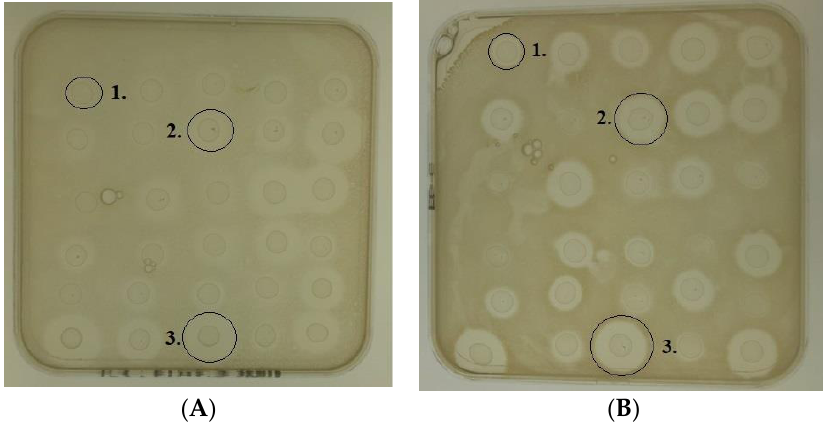
Figure 1. Representative pictures of the agar based deferred antagonism assays that were performed with a wildtype producing L. lactis strain and 29 L. lactis strains that produce bioengineered nisin A derivatives. These strains were spotted onto GM17 agar and grown at 30 ◦ C overnight after which they were overlaid with tryptone soy agar (TSA) inoculated with ( A ) Staphylococcus epidermidis 28 and ( B ) Staphylococcus epidermidis 53. Overlaid plates were incubated for 18 h at 37 ◦ C. Zones of inhibition from the (1) nisin A producing strain (2) M21V producing strain and (3) M17Q producing strain are circled.